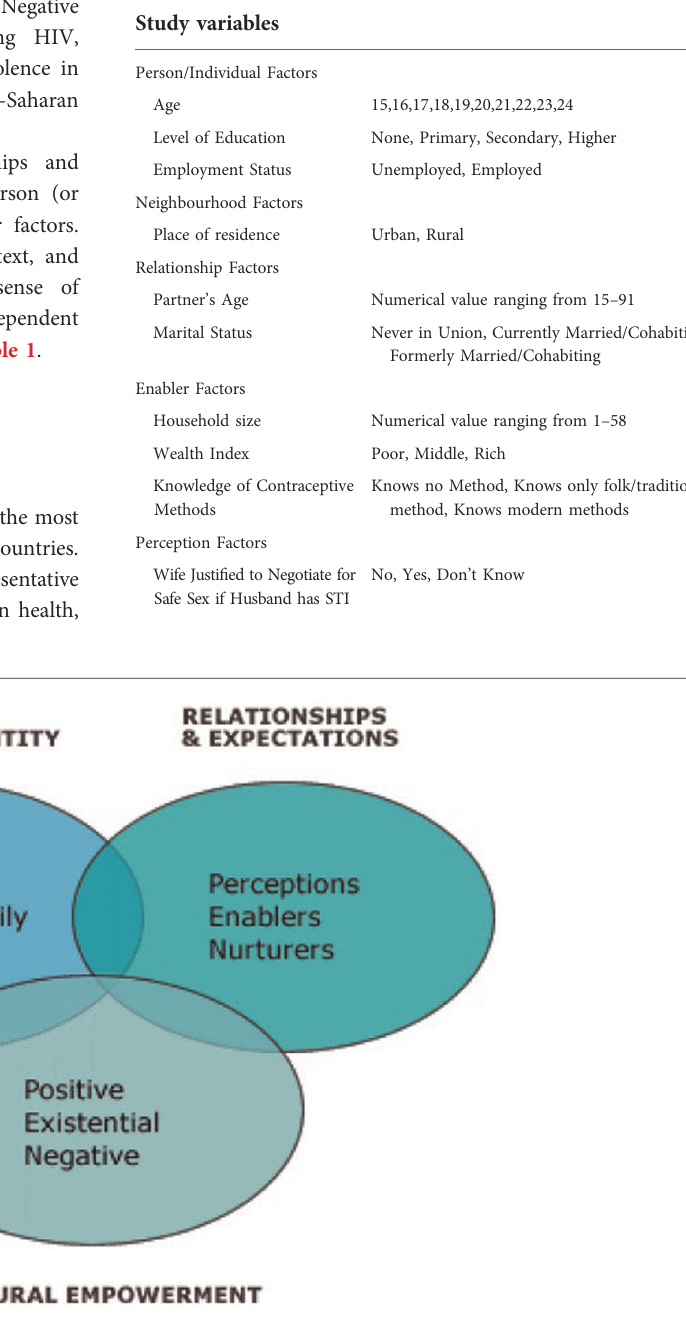
TABLE 1 Variable identi fi cation for the